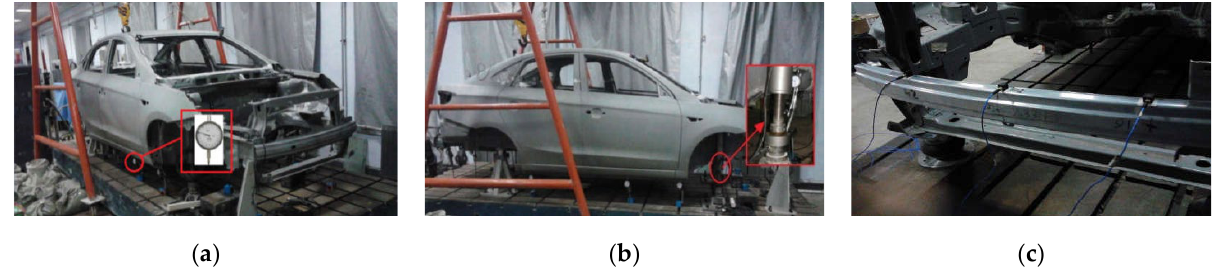
Figure 16. Static stiffness and low-order modal test of BIW: ( a ) Bending stiffness test; ( b ) Torsional stiffness test; ( c ) Low-order modal frequency test. Table 5. Test results of static stiffness and low-order modal frequency of BIW.